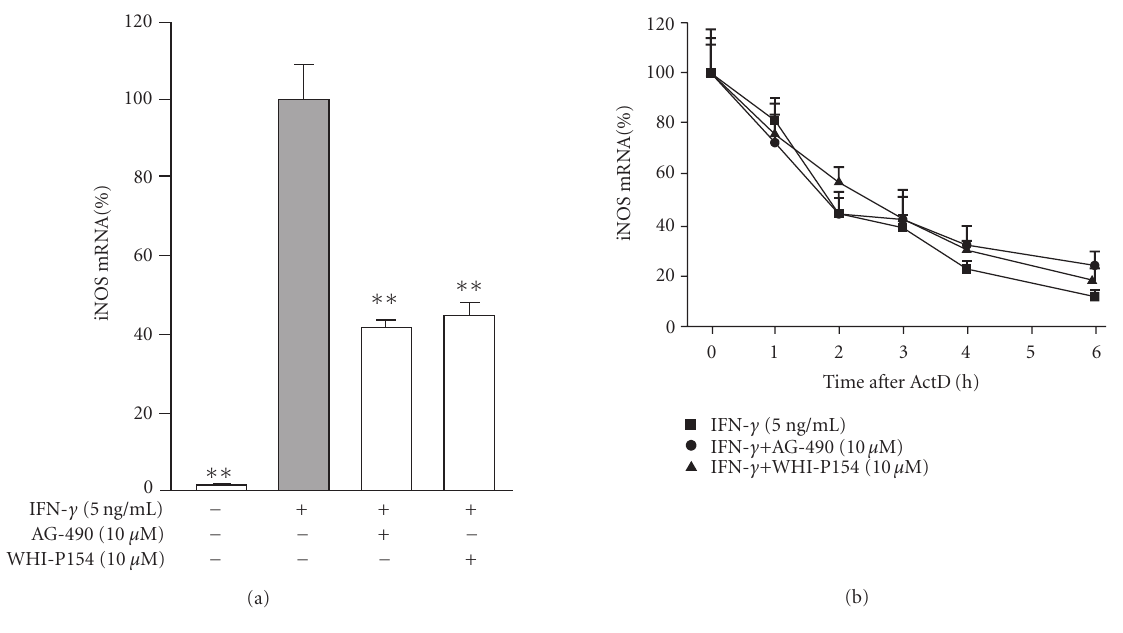
Figure 5: E ff ects of JAK inhibitors, AG-490 and WHI-P154, on IFN- γ -induced iNOS mRNA expression and degradation in J774 macrophages. (a) Cells were incubated with IFN- γ (5ng/mL) in the absence or in the presence of AG-490 and WHI-P154 (10 μ M). The cells were disrupted after 4-hour incubation and total RNA was collected. Isolated RNA was converted to cDNA. iNOS and GAPDH mRNAs were measured by quantitative PCR, and iNOS mRNA levels were normalized against GAPDH mRNA. The results are expressed as mean ± SEM, n = 3. ∗∗ P < . 01 when compared to cells treated with IFN- γ alone. (b) Cells were incubated as in (a) except that actinomycin D (actD) (0.1 μ g/mL) was added after 6-hour incubation to stop transcription. Incubations were terminated at the indicated time points after addition of actD into the culture medium. Total RNA was isolated and converted to cDNA. iNOS and GAPDH mRNA were measured by quantitative PCR. iNOS mRNA levels were normalized against GAPDH mRNA. The results are expressed as mean ± SEM, n =